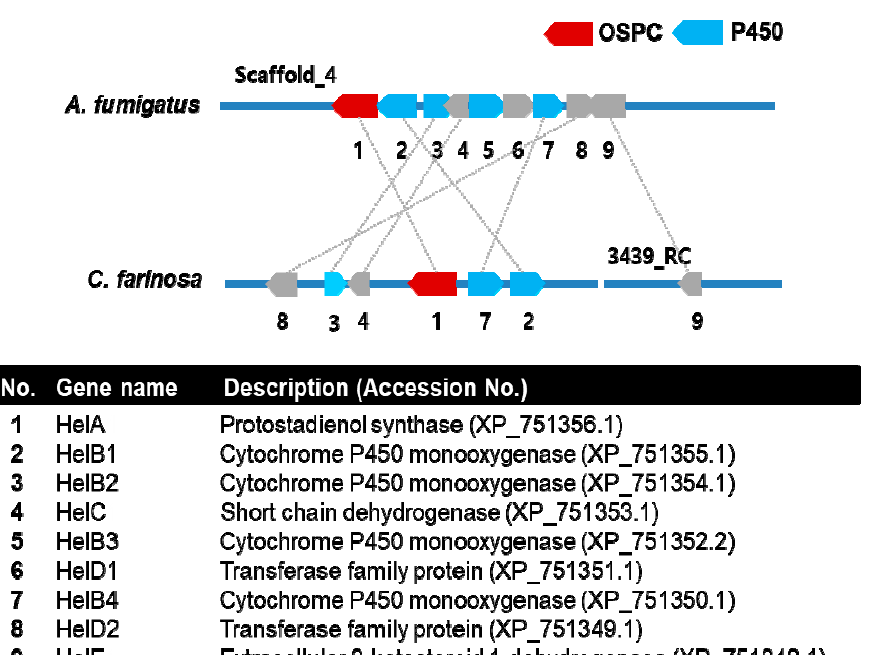
Figure 6. Synteny comparison of two gene clusters involved in triterpenoid biosynthesis.